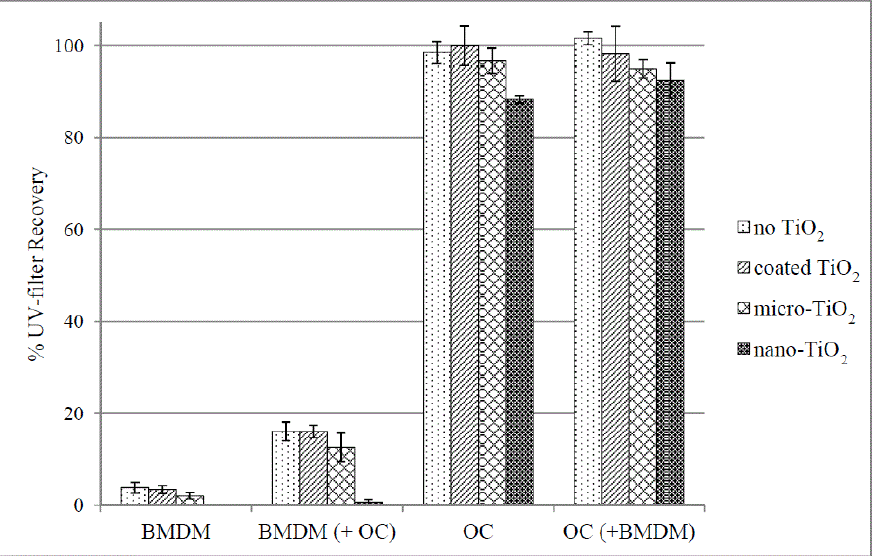
Figure 3. % Recovery ± SD of BMDM and OC after irradiation in the solar